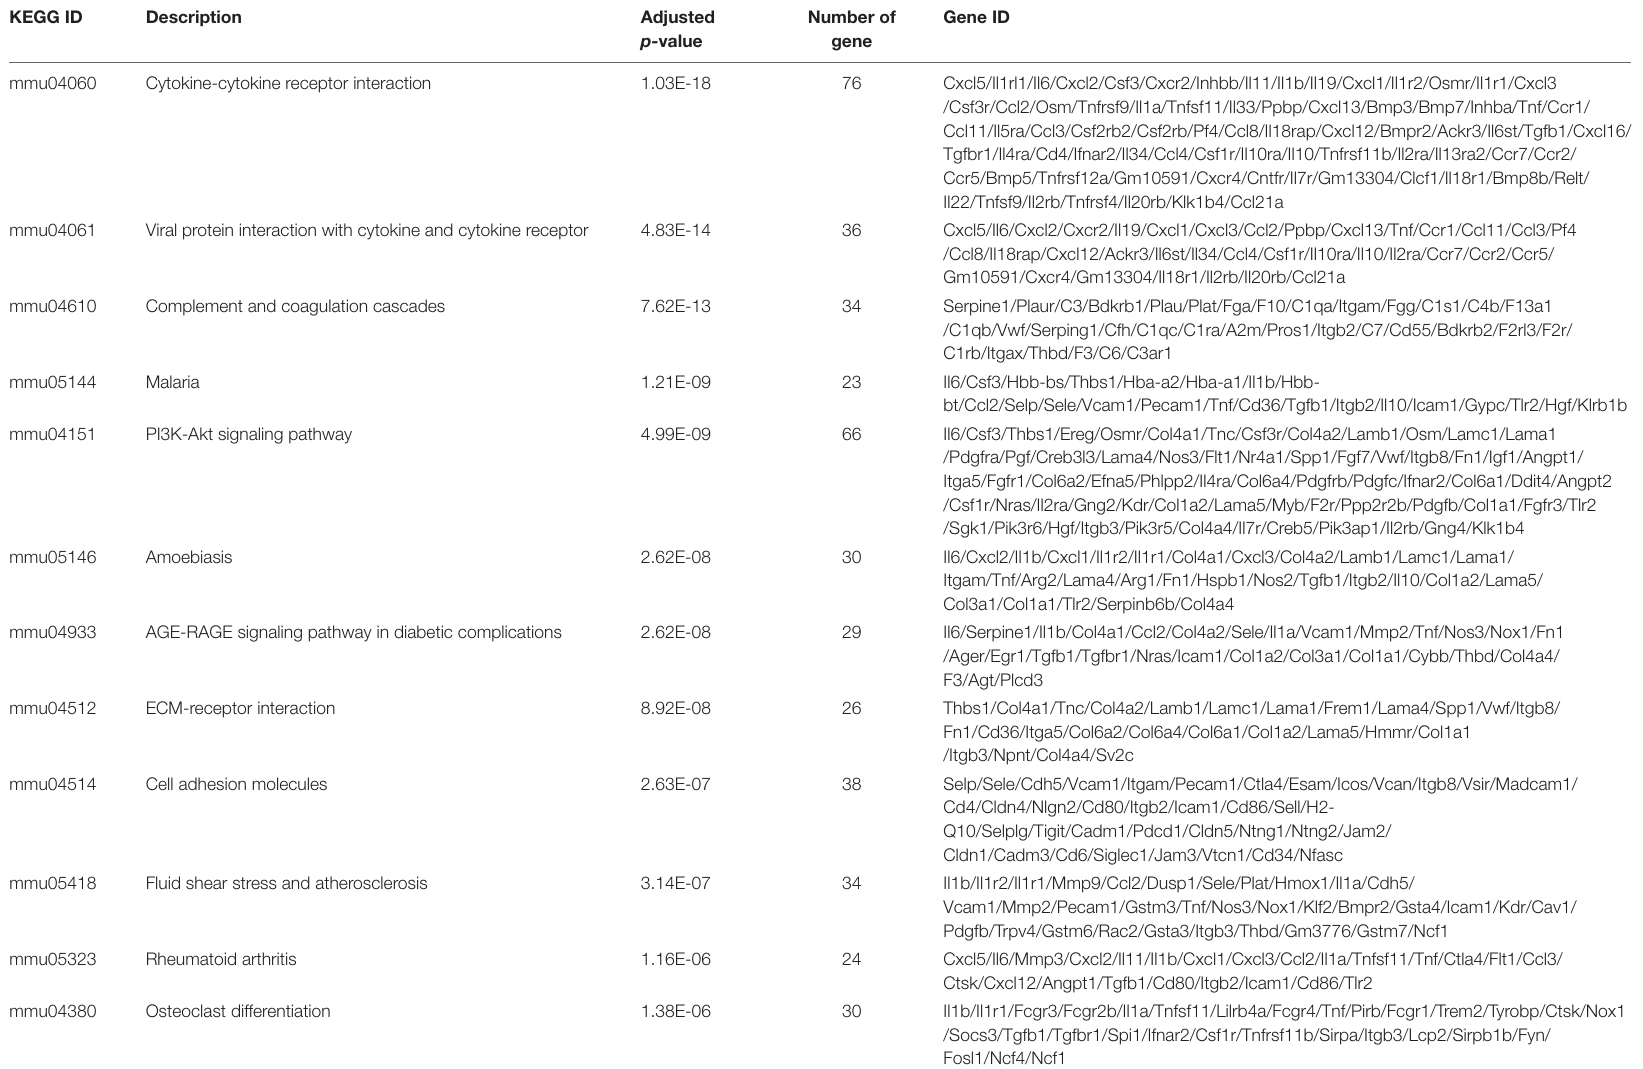
TABLE 2 | Alterations of cell signaling pathways in gut caused by